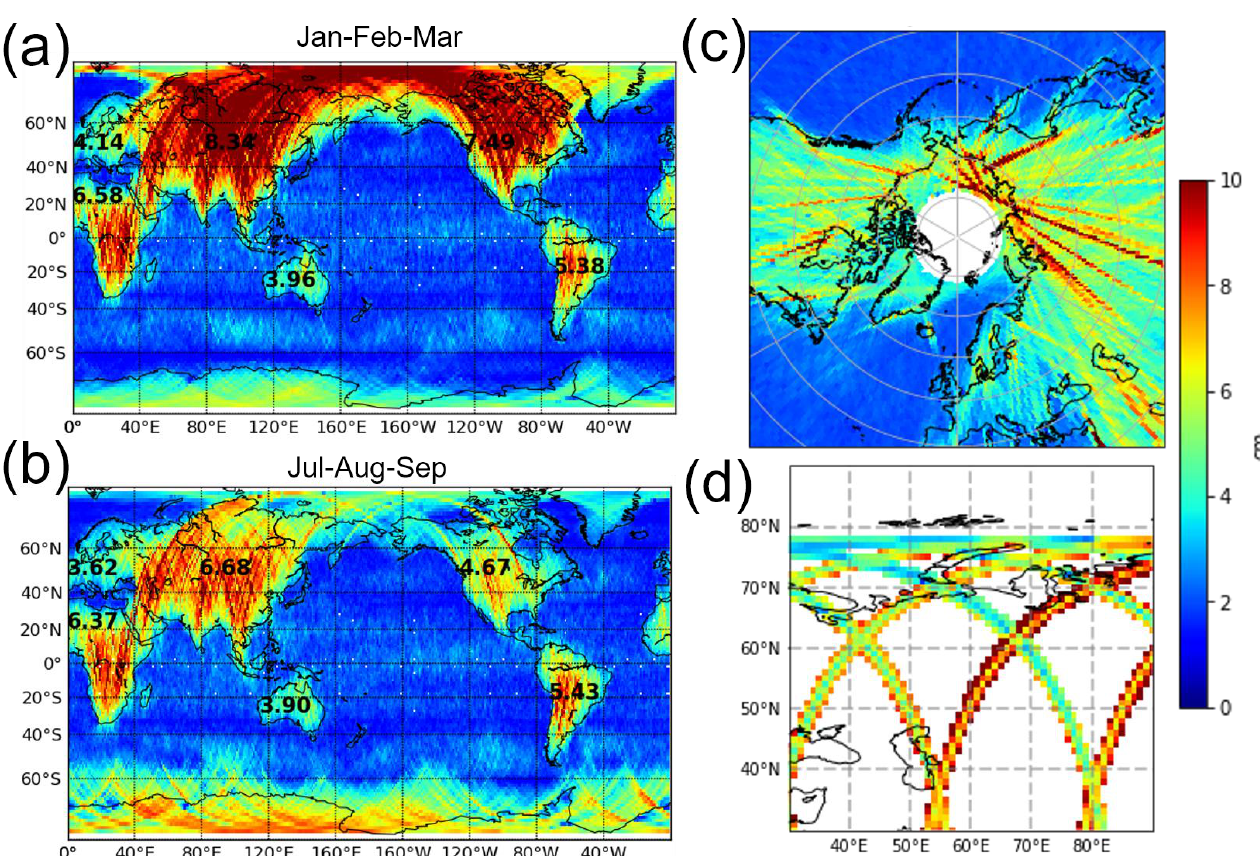
Figure 16. Seasonal variations of the systematic errors after the Level-2 data-driven calibration is applied (unit: cm RMS). Panel ( a ) is the same as Figure 15 for January to March (wintertime in the Northern hemisphere) and panel ( b ) is for July to September (wintertime in Southern hemisphere). Panel ( c ) is a snapshot for an arbitrary cycle during the transition from panel ( a ) to panel ( c ). Panel ( d ) shows a zoom over Eurasia for an arbitrary cycle of the one-day orbit.